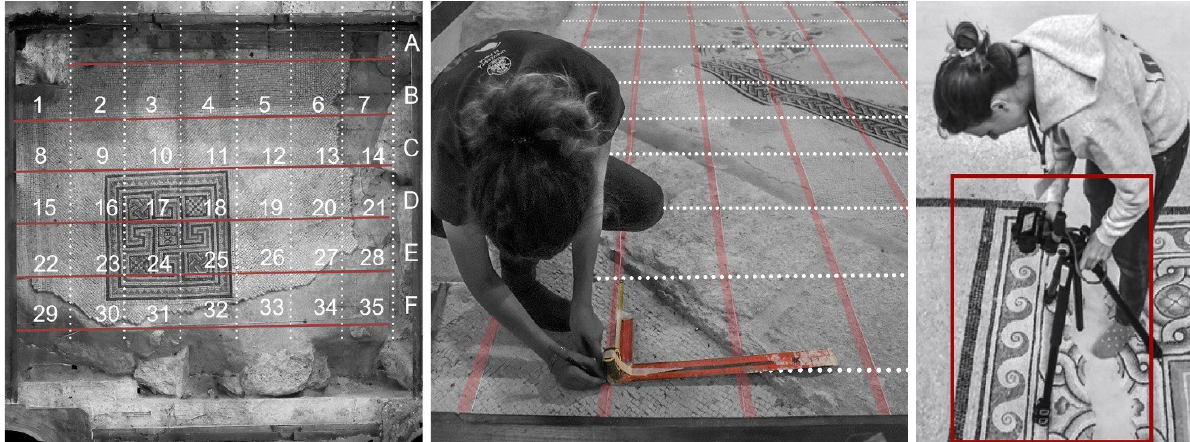
Figure 8. Subdivision of the mosaics into regular squares for the reference of each square. Partition and acquisition of the squares